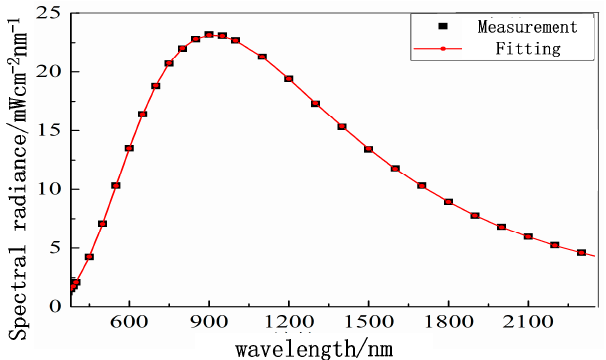
Figure 8. Spectral radiance inversion of the tungsten halogen lamp.